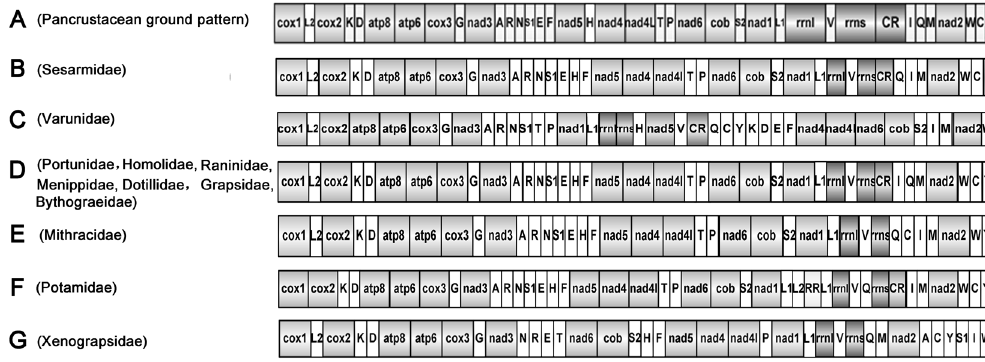
Figure 4. Linear representation of gene rearrangements of Brachyura mitogenomes. All genes are transcribed from left to right. tRNA genes are represented by the corresponding single-letter amino acid code. S1 = AGN, S2 = UCN, L1 = CUN, L2 = UUR. CR = control region. rrnL and rrnS are the large and small ribosomal RNA subunits.